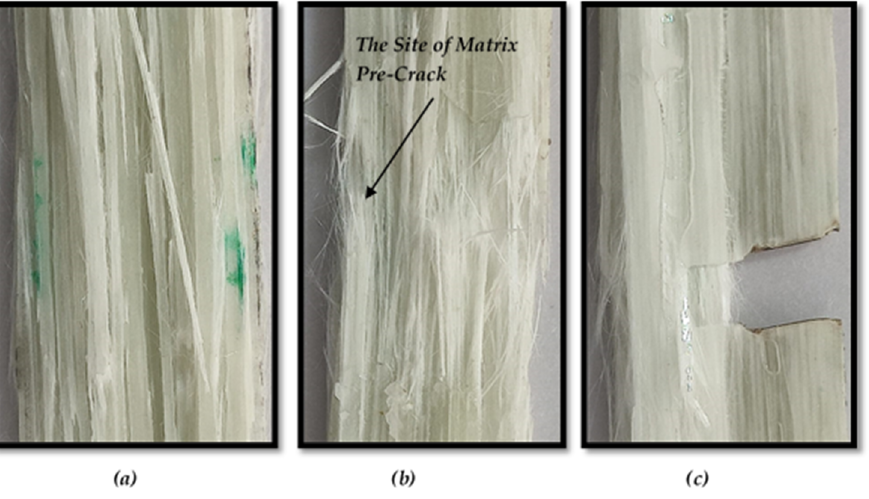
Figure 11. Close-up view of experimental final failure shape of ASTM D3039 for ( a ) Smooth specimen, ( b ) MC specimen, and ( c ) TTC specimen.